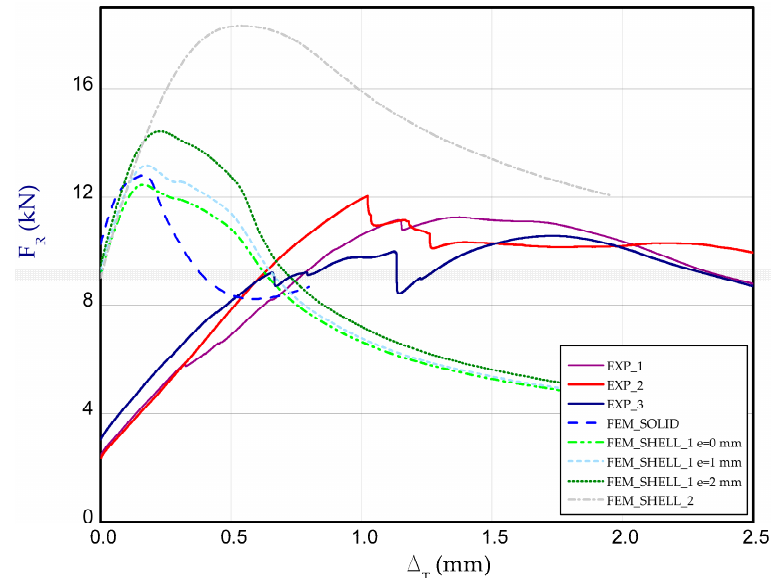
Figure 14. The compression curves of column at 75 °C.